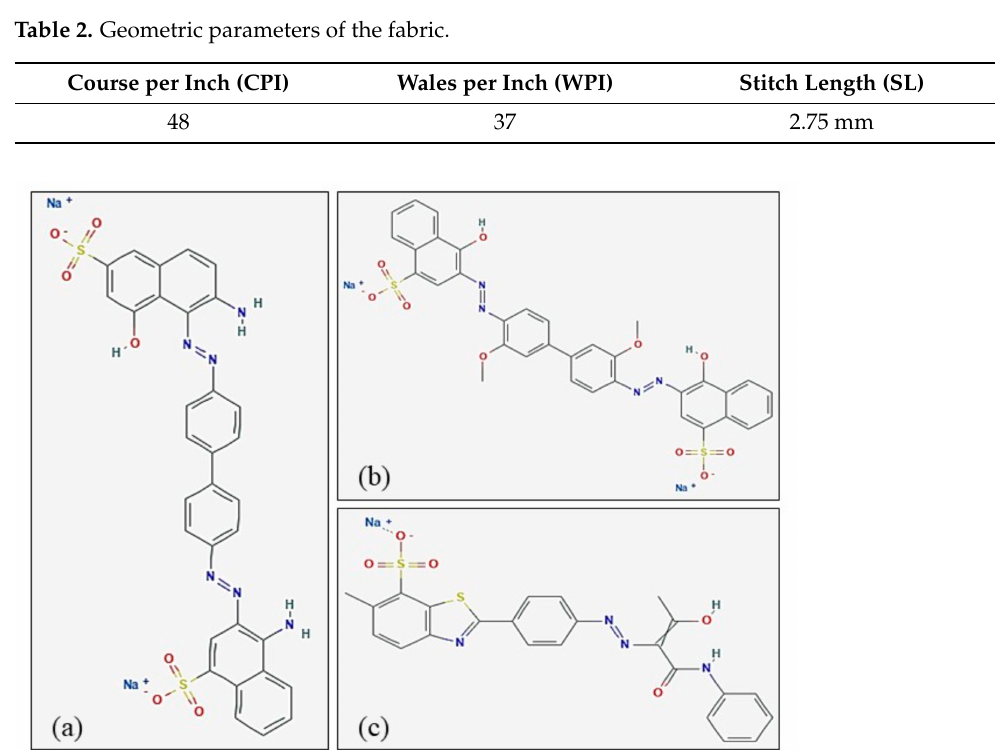
Figure 1. Chemical structure depiction of ( a ) C.I. Direct Red 13, ( b ) C.I. Direct Blue 8, and ( c ) C.I. Direct Yellow